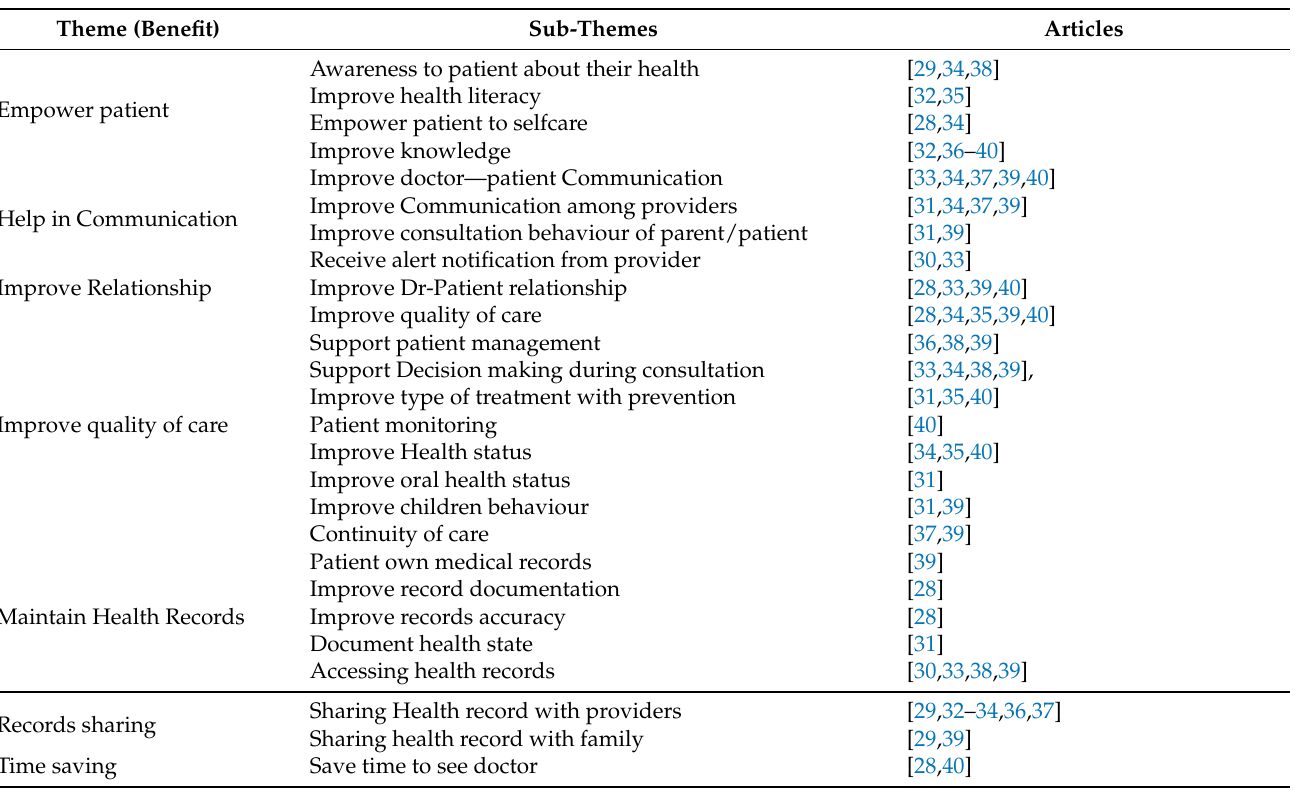
Table 2. Analysis results for benefits of using digital personal health